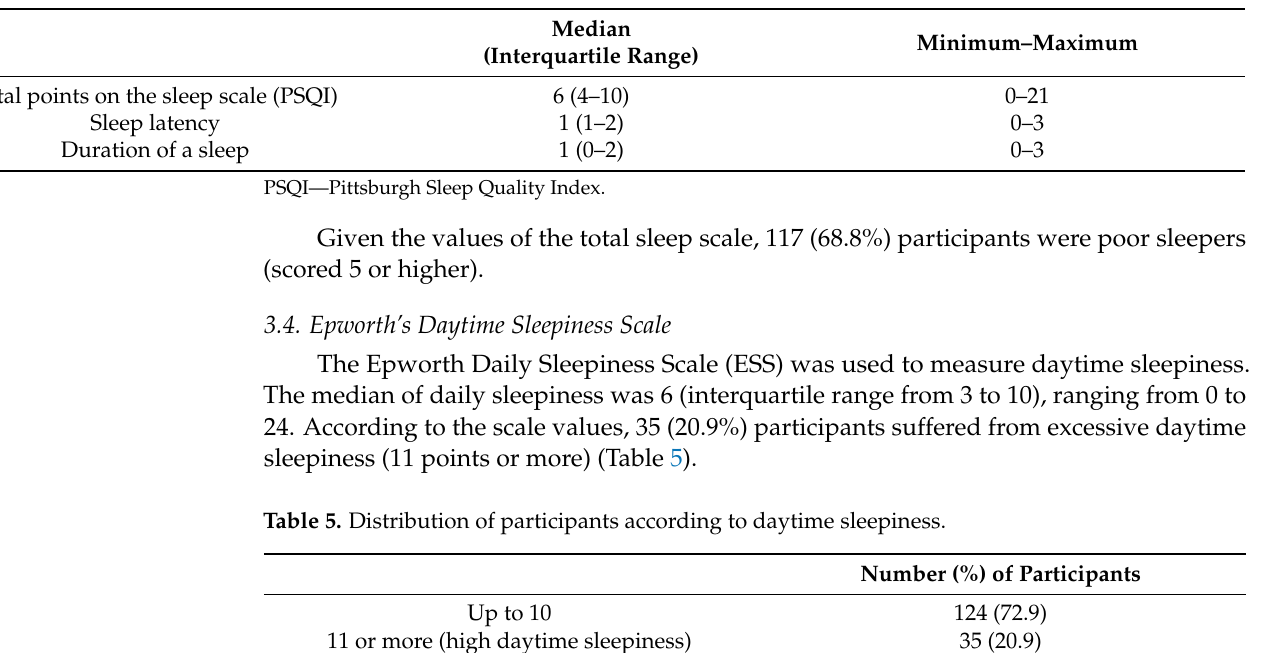
Table 4. Evaluation of total sleep quality scale, sleep latency, and duration of sleep (in the number of points) of HD patients (PSQI).